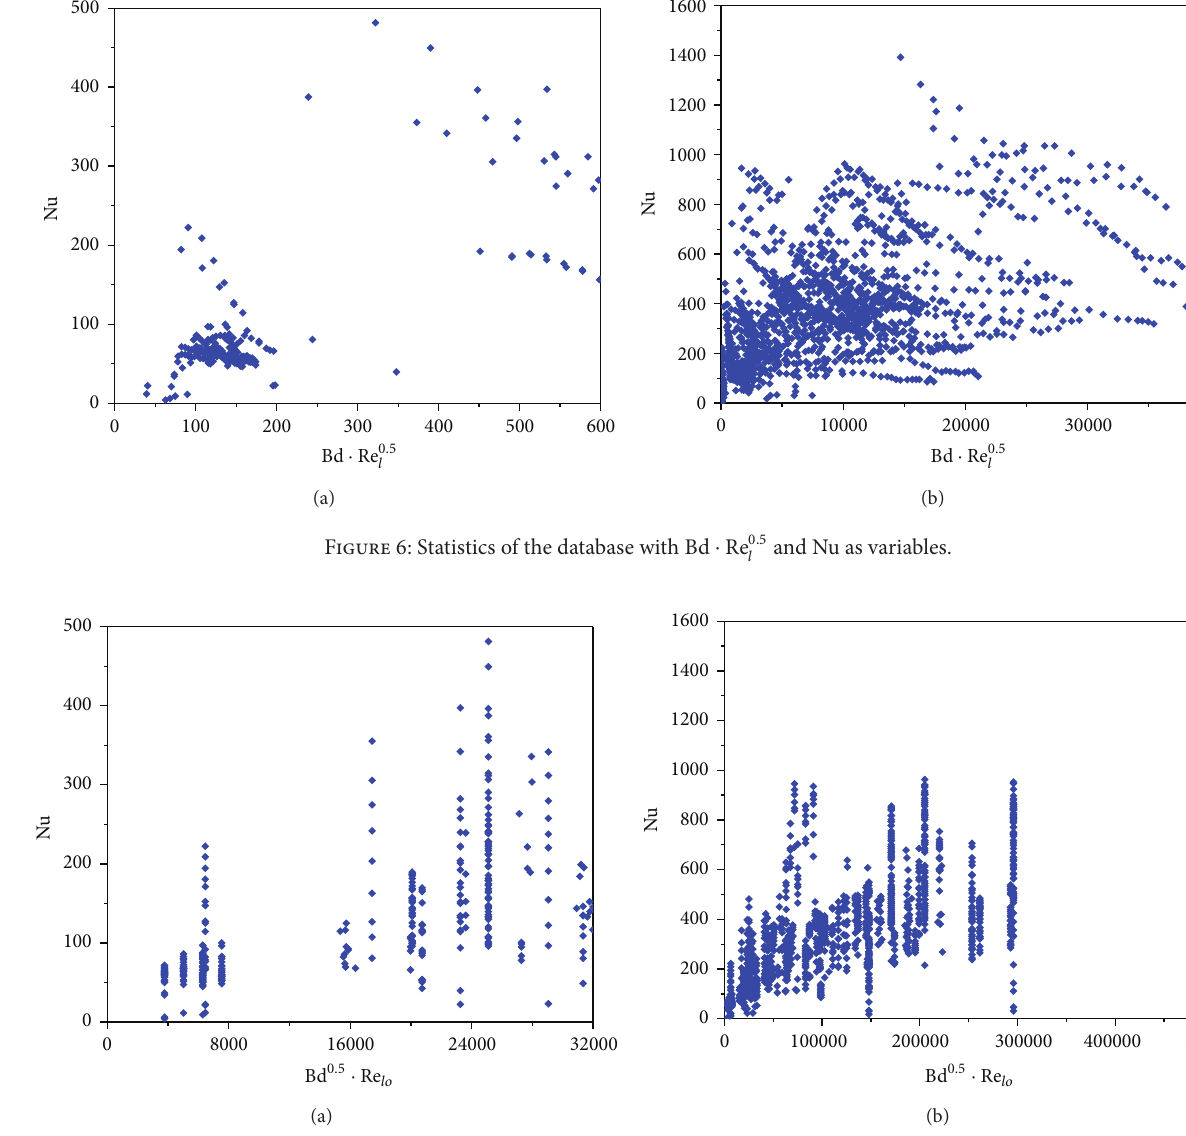
Figure 7: Statistics of the database with Bd 0.5 ⋅ Re 𝑙𝑜 and Nu as